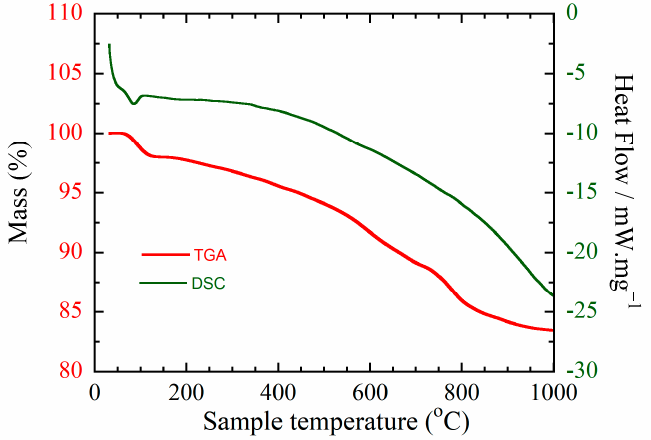
Figure 1. TG/DSC curves of the precursors.